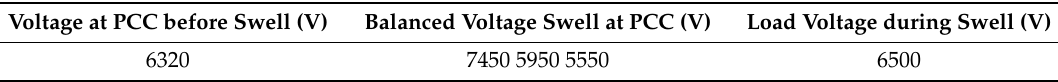
Table 3. RMS Voltage of Case 5-Unbalanced Voltage Swell.